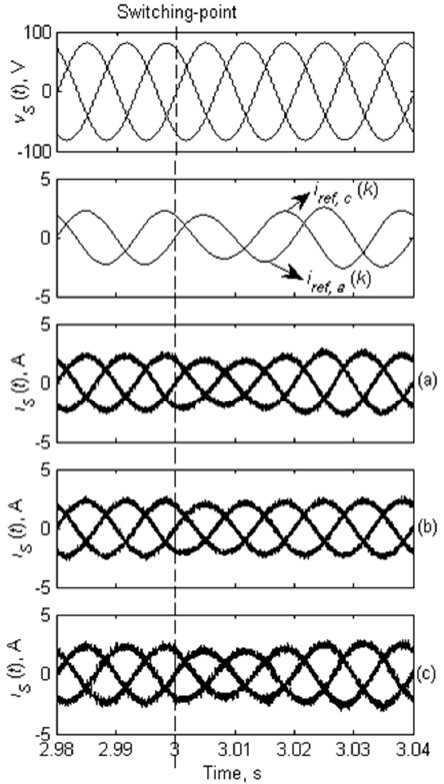
Figure 12. Simulated dynamic-state 3-phase v S ( t ) , 2 phases i ref , ix ( k ) , and 3-phase i S ( t ) waveforms Figure 12. Simulated dynamic ‐ state 3 ‐ phase (cid:1874) (cid:3020) (cid:4666)(cid:1872)(cid:4667) , 2 phases (cid:1861) (cid:3045)(cid:3032)(cid:3033),(cid:3036)(cid:3051) (cid:4666)(cid:1863)(cid:4667) , and 3 ‐ phase (cid:1861) (cid:3020) (cid:4666)(cid:1872)(cid:4667) waveforms Figure 12. Simulated dynamic ‐ state 3 ‐ phase (cid:1874) (cid:3020) (cid:4666)(cid:1872)(cid:4667) , 2 phases (cid:1861) (cid:3045)(cid:3032)(cid:3033),(cid:3036)(cid:3051) (cid:4666)(cid:1863)(cid:4667) , and 3 ‐ phase (cid:1861) (cid:3020) (cid:4666)(cid:1872)(cid:4667) waveforms during the switching between Load 1 and Load 2. The SAPF applies the ( a ) proposed, ( b ) Fuzzy-PI or during the switching between Load 1 and Load 2. The SAPF applies the ( a ) proposed, ( b ) Fuzzy ‐ PI during the switching between Load 1 and Load 2. The SAPF applies the ( a ) proposed, ( b ) Fuzzy ‐ PI ( c ) Crisp-PI CCA. or ( c ) Crisp ‐ PI CCA. or ( c ) Crisp ‐ PI CCA.